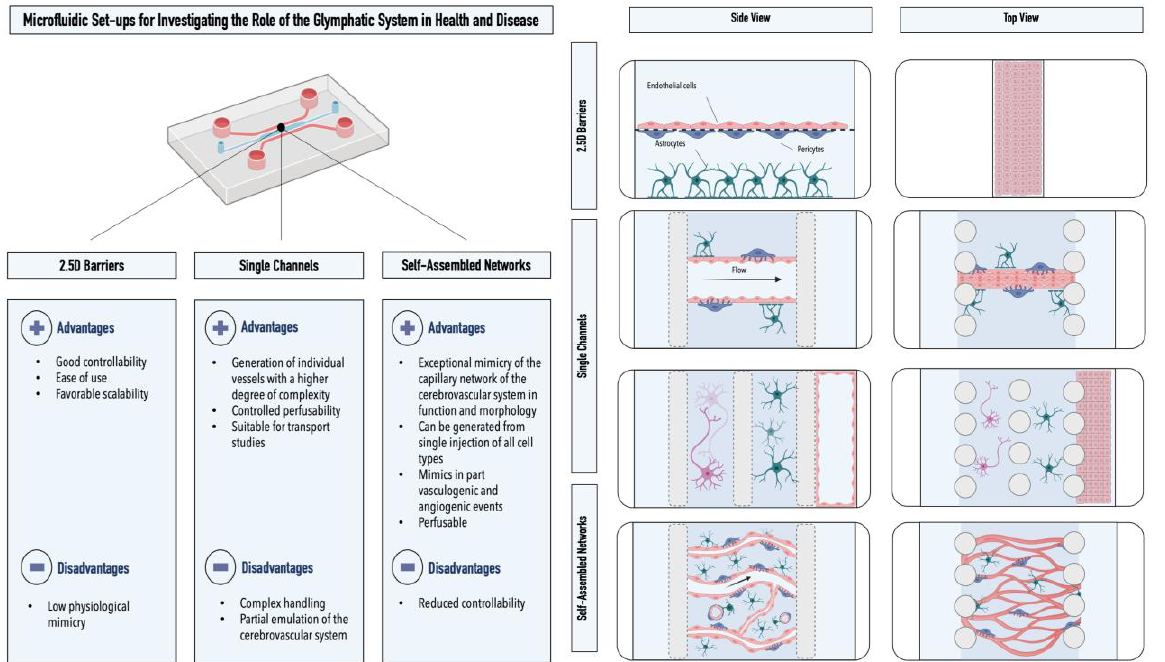
Figure 3. Advantages and disadvantages of microfluidic models of the cerebrovascular system. Graphical illustrations represent the three different microfluidic setups utilized for the emulation of the cerebrovascular system in vitro: 2.5D barrier set-ups, single-channel devices, and self-assembled networks. Astrocytes are depicted in green, endothelial cells in pink, and pericytes in lilac.